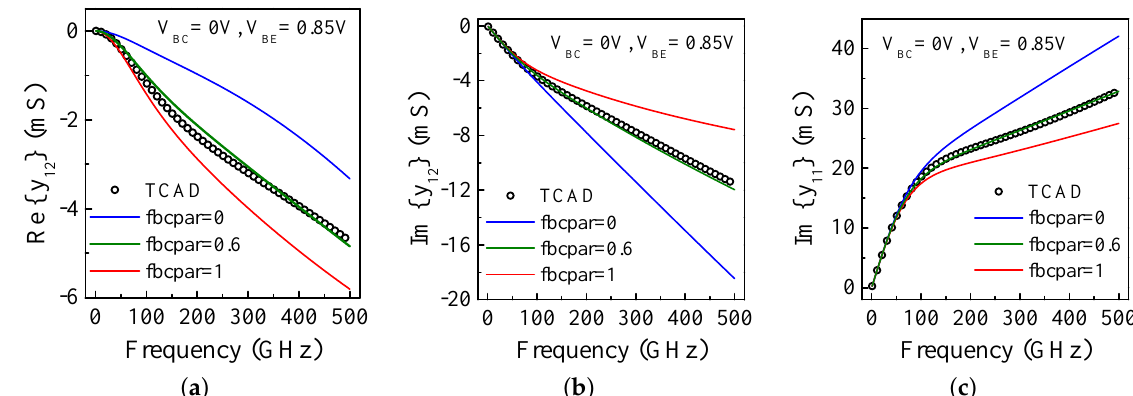
Figure 14. Sensitivity of fbcpar on frequency dependent (cid:60) y 12 ( a ), (cid:61) y 12 ( b ) and (cid:61) y 11 ( c ) for the 0.09 µ m × 4.8 µ m SiGe HBT biased at V BC = 0 V with V BE = 0.85 V: comparison between TCAD (circles) and Hicum L2v2.4 (solid line).